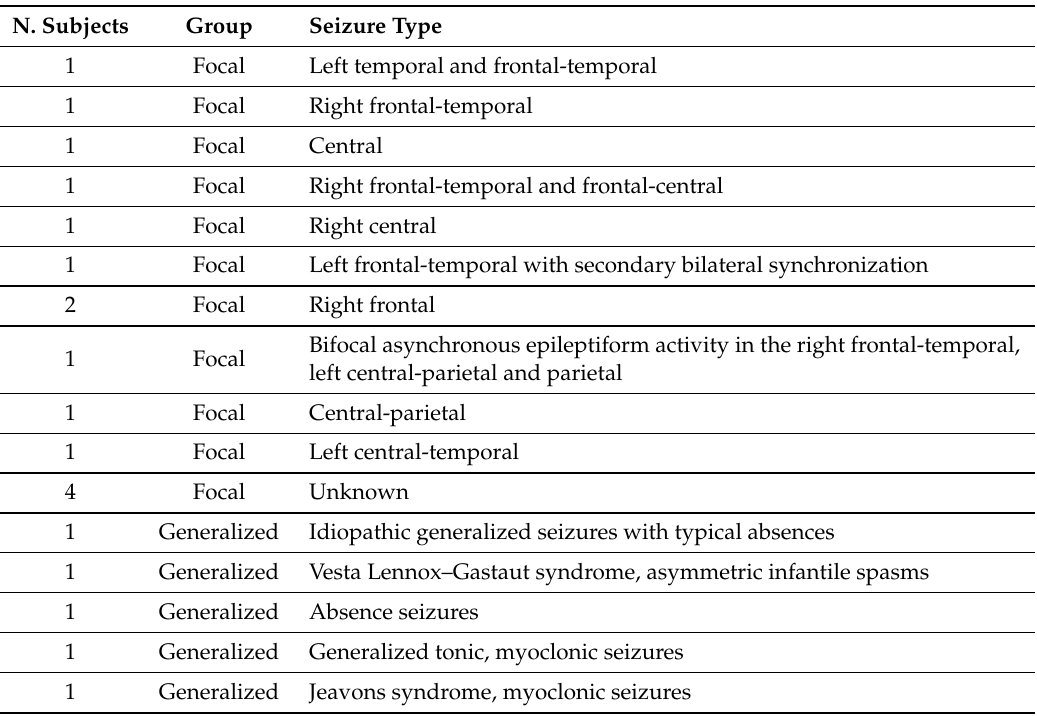
Table 1. Information about seizures type and